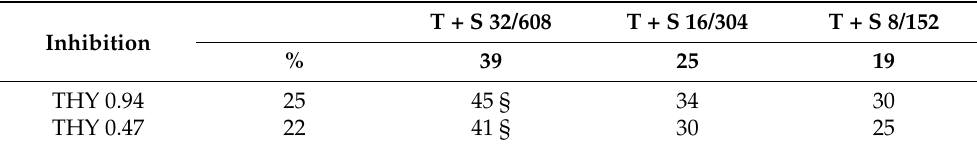
Table 4. Percentage inhibition of the five ETEC strains resistant to trimethoprim + sulfamethoxazole in the presence of combinations of the two antibiotics (T + S, mg/L) and thymol (THY, mM). T + S 32/608 T + S 16/304 T + S 8/152 Inhibition % 39 25 19 THY 0.94 25 45 § 34 30 THY 0.47 22 41 § 30